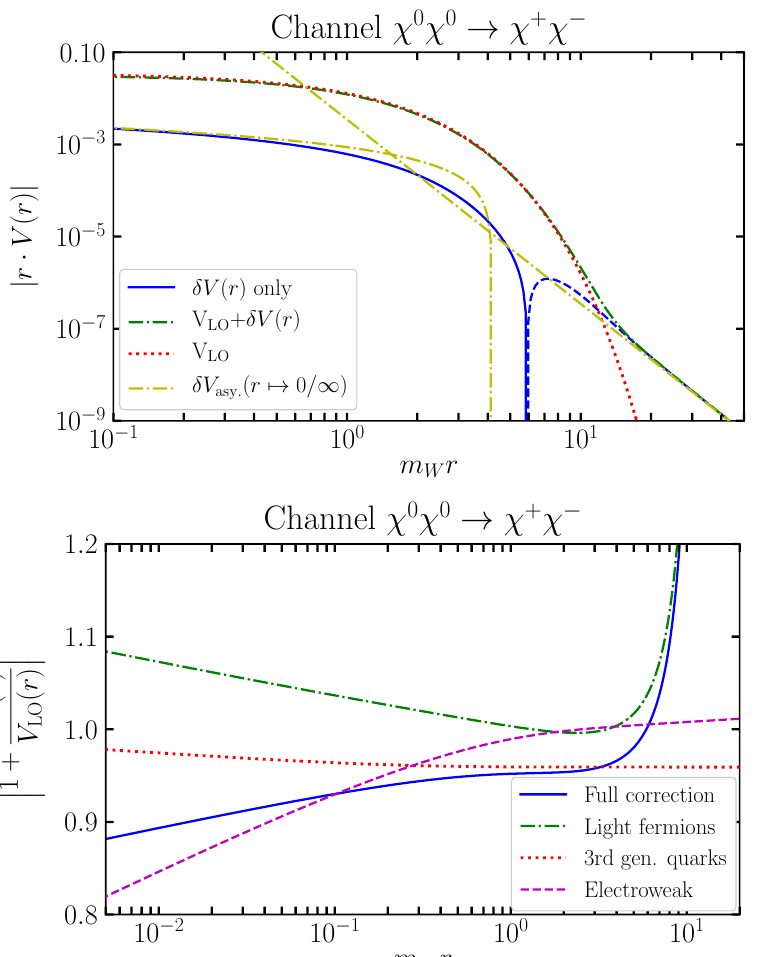
Figure 3 . The NLO correction to the potential in the channel χ 0 χ 0 → χ + χ − . The upper panel shows the modulus of the potential | r · V ( r ) | for the LO and NLO potential, the NLO contribution only and the asymptotic behaviours. The change from solid to dashed for the blue δV ( r ) curve marks its change of sign. In the lower panel, we show the ratio of the NLO to the LO potential for the full correction, and for the three gauge-invariant pieces, which illustrates their different